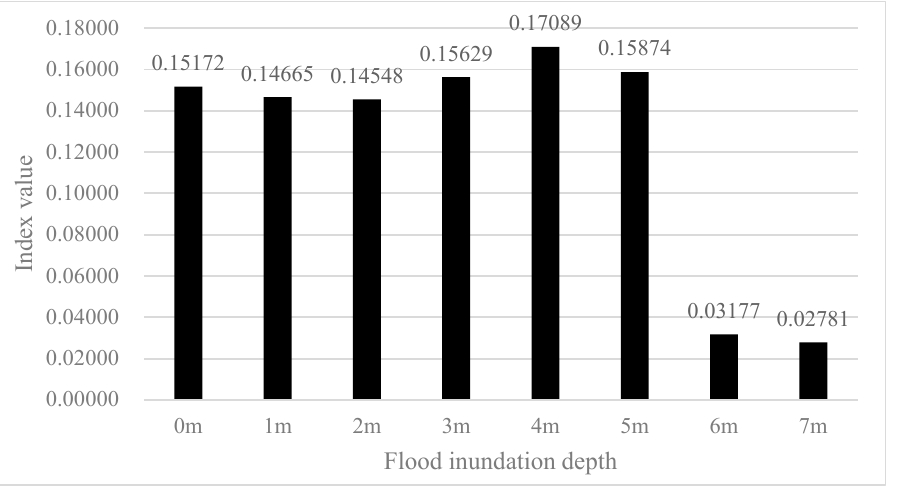
Figure 9. Analysis results of the road network hub for the study area (Source: self-drawn by the author).